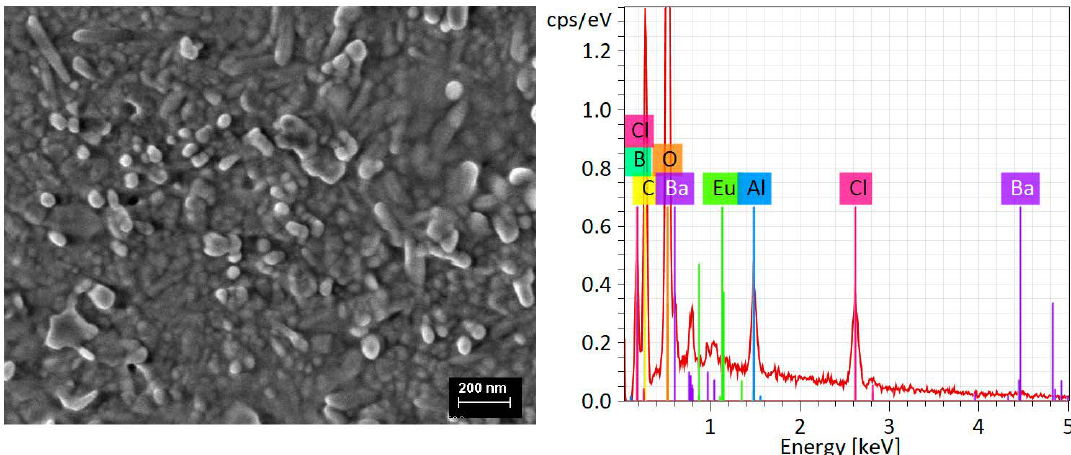
Figure 3. Scanning electron microscopy (SEM) image (cross-section) of the chloroborate glass-ceramic annealed at 555 °C ( left ) and the corresponding EDX analysis with the characteristic x-ray lines assignment ( right ).